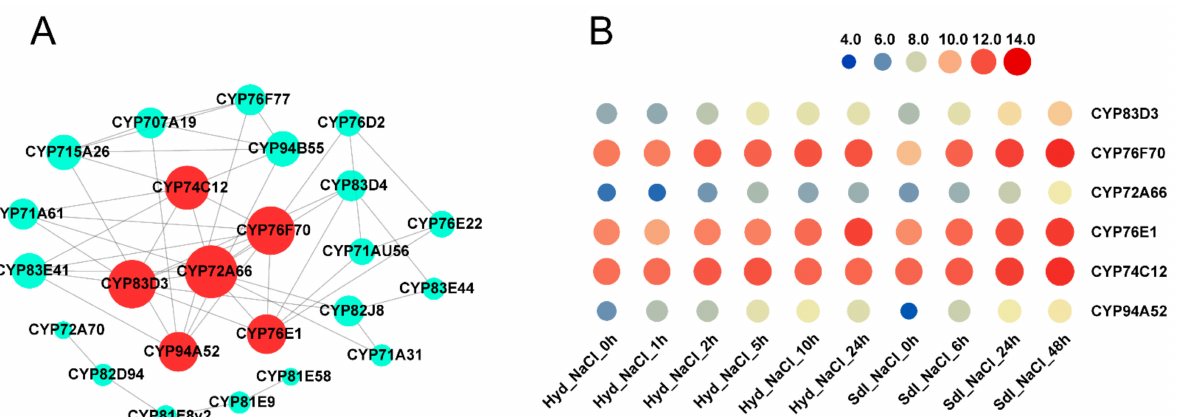
Figure 6. Co-expression network analysis and hierarchical clustering of expression profiles of MtP450 genes under drought treatments from microarray data. ( A ) Weighted gene co-expression network analysis of genes in shoots; ( B ) weighted gene co-expression network analysis of genes in roots; ( C ) Venn diagram showing MtP450 genes in shoots and roots under drought treatments through co-expression; ( D ) hierarchical clustering of expression profiles of MtP450 genes under drought treatments from microarray data.